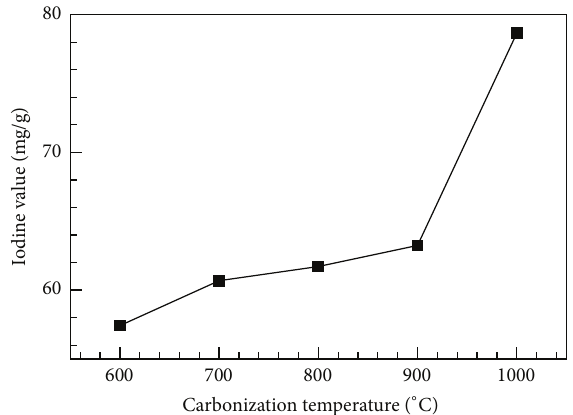
Figure 5: Ash content as a function of carbonization temperature.